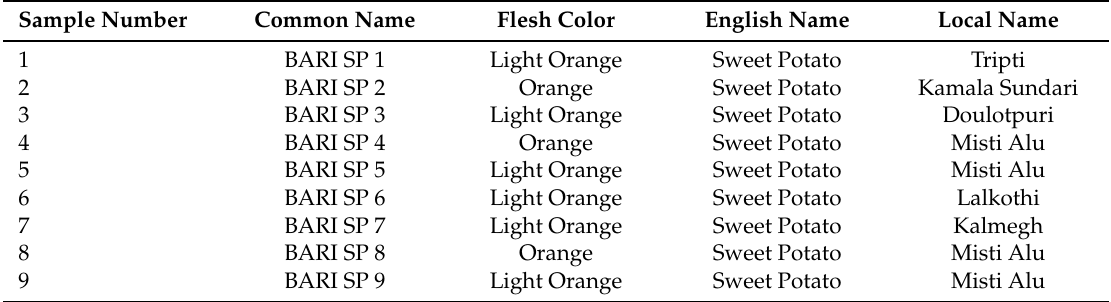
Table 1. The flesh color, common and local names of the nine varieties of orange-fleshed sweet potato grown in Bangladesh. BARI, Bangladesh Agricultural Research Institute; SP, sweet